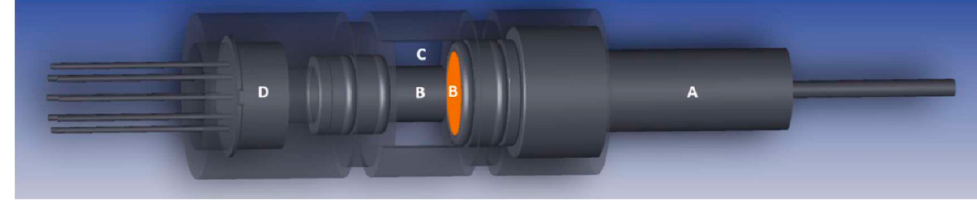
Figure 8. Sectional diagram of a microsensor. А —light source, B—sapphyric glass ( right ) and rod ( left ), C—space for liquid, D—quad-core photo receiver [108]. ( left ), C—space for liquid, D—quad-core photo receiver